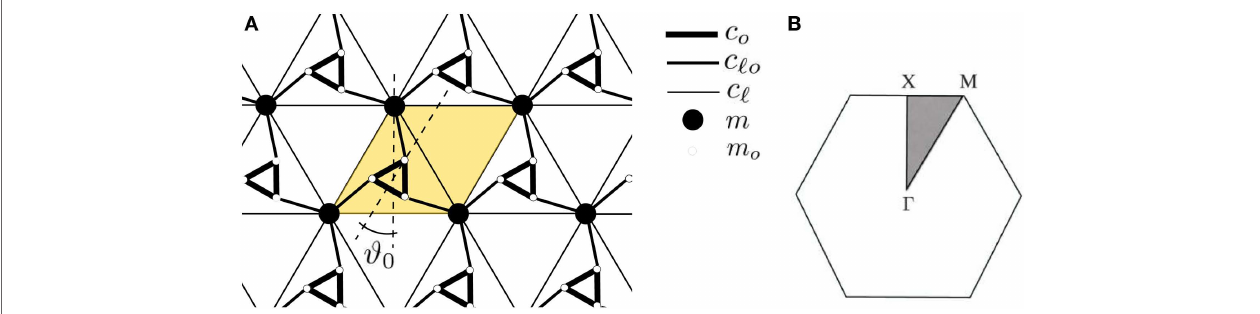
FIGURE 1 | (A) A schematic representation of the triangular elastic lattice containing resonators, tilted by an angle ϑ 0 ; the unit cell of the lattice is highlighted in yellow. (B) The first Brillouin zone for the triangular lattice and irreducible fraction (gray-shaded region).